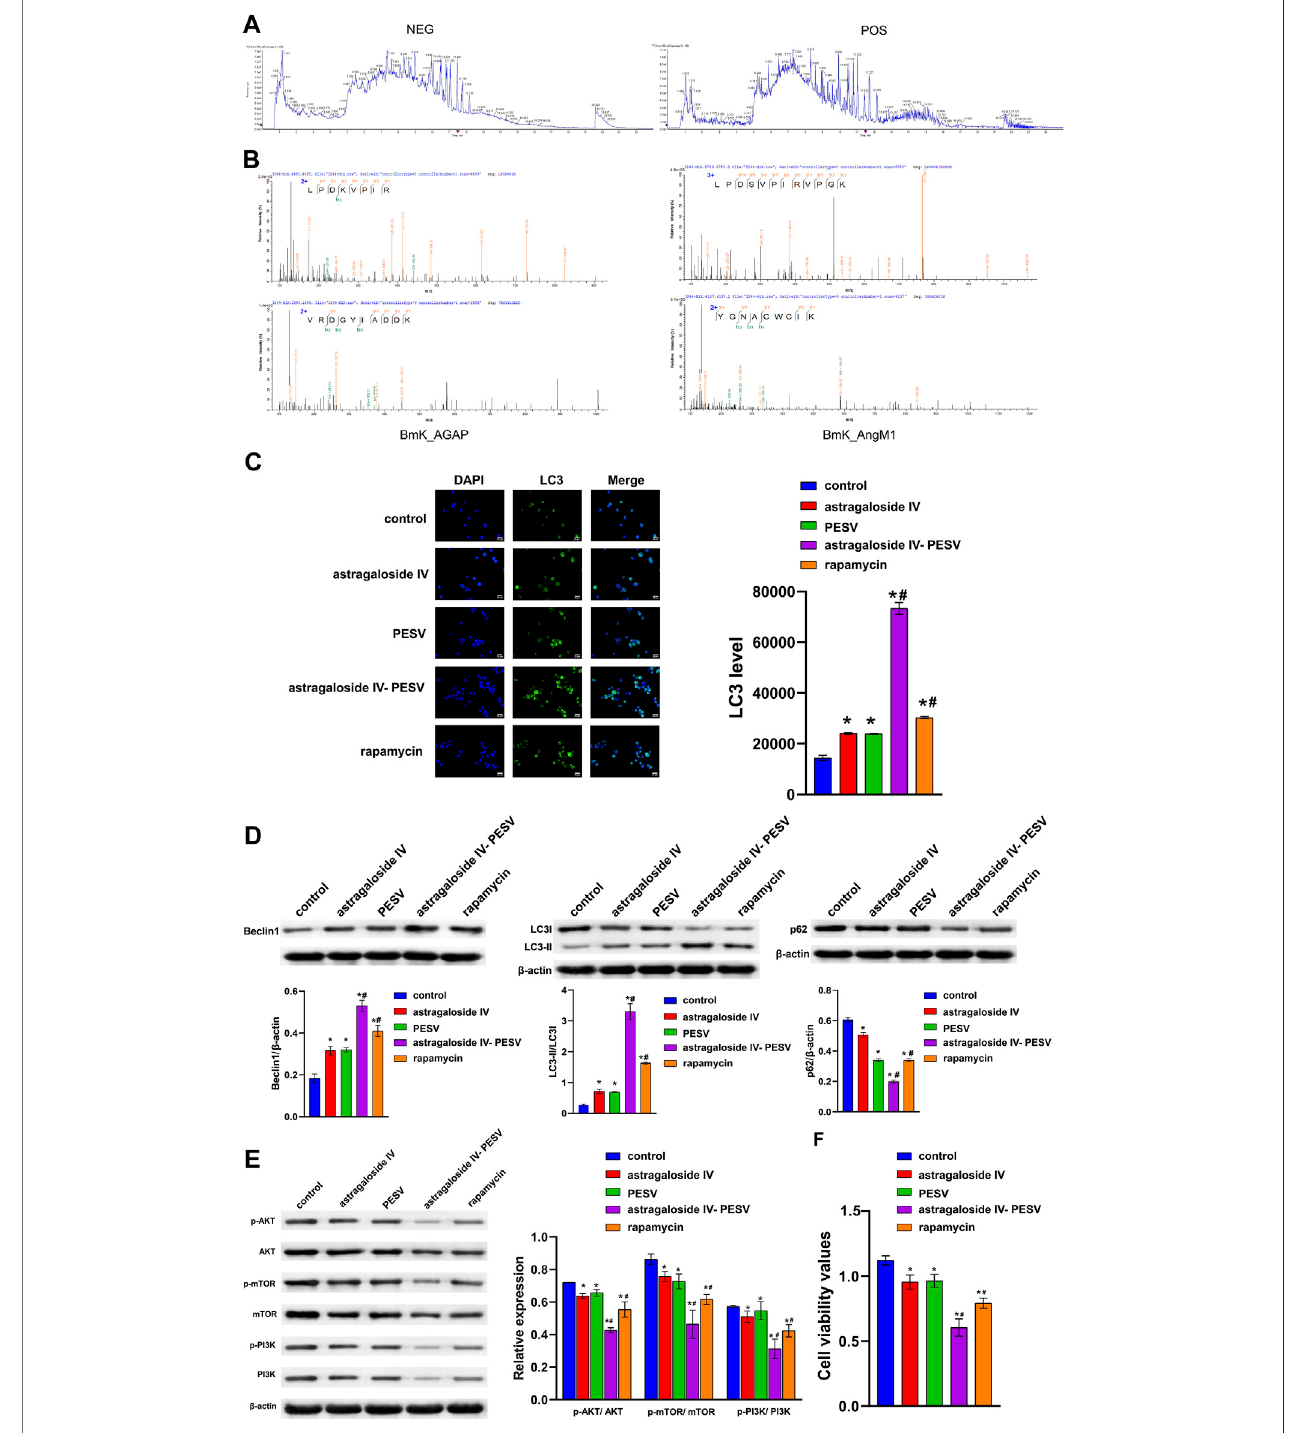
FIGURE 3 | The main bio-active components in the herb pair A – S suppressed LNCaP cell proliferation and migration through the PI3K/AKT/mTOR pathway. (A) LC – MS/MS chromatogram of the bio-active components in Astragalus. (B) The LC-MS/MS analysis of PESV in scorpion. (C) LC3 and DAPI immuno fl uorescence stainingwere performed to detect autophagy. (D) The LC3, Beclin1, and P62expression weredetermined bywestern blot. (E) The protein expression ofthe PI3K/AKT/ mTOR signaling pathway. (F) Cell activity was determined by the CCK8 assay. * p < 0.05 vs. control group, # p < 0.05 vs. Astragaloside IV or PESV groups.